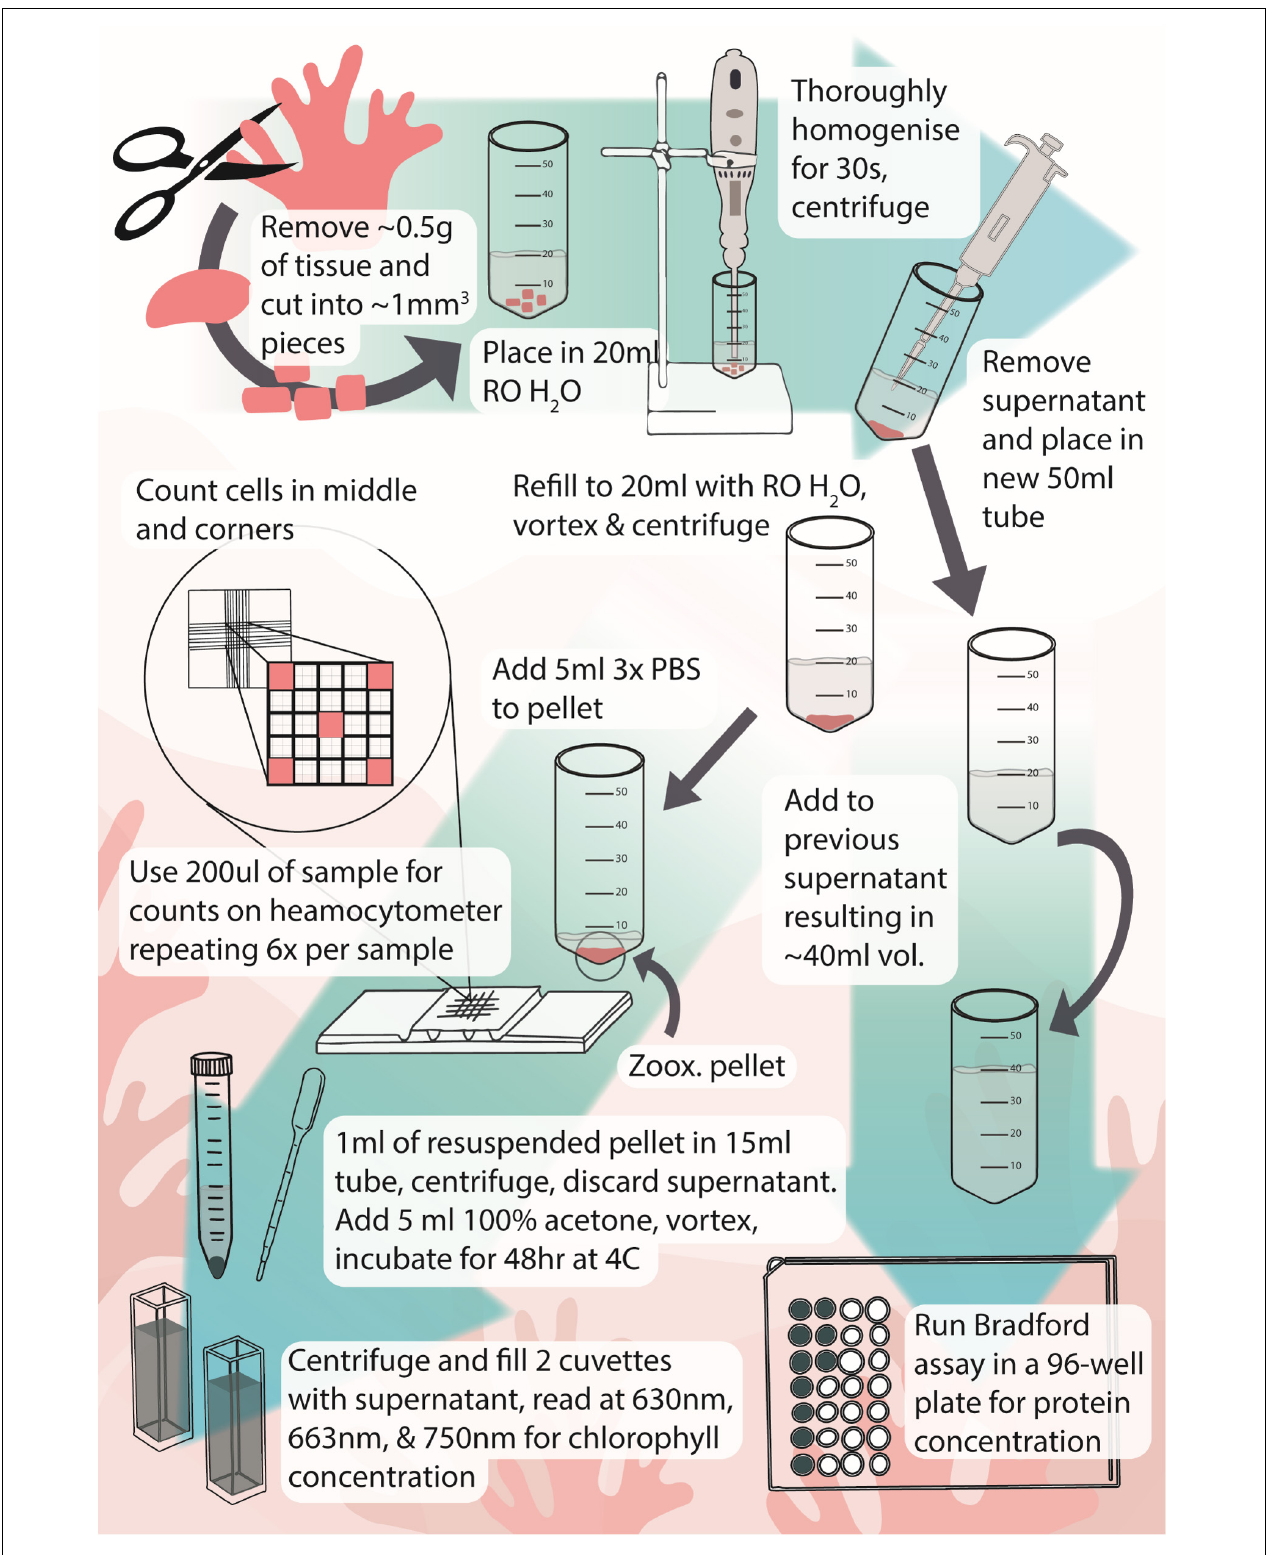
FIGURE 4 | Infographic of protocol for extraction and measurement of Symbiodiniaceae and chlorophyll from octocorals. Icons and infographic by Melissa Pappas, EmergingCreativesOfScience.com.